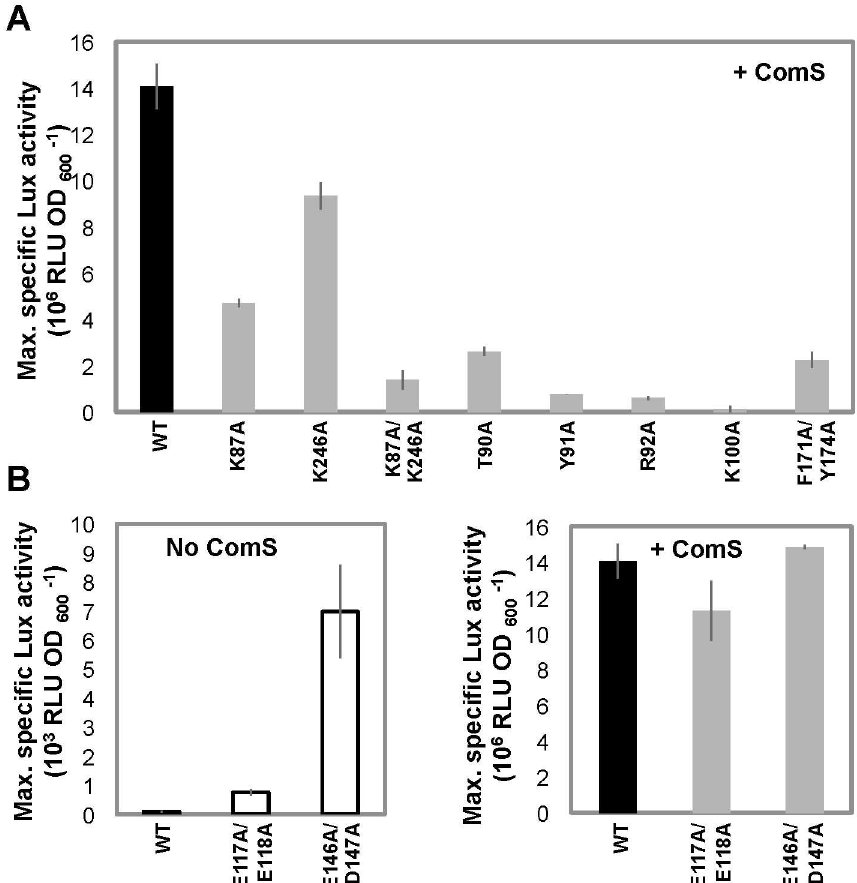
Fig 6. In vivo transcriptional activity. A– In vivo activities of ComR mutants affected in dimerization, XIP binding and activation mechanism. Maximum specific luciferaseactivity (RLU OD 600-1 ) emitted by the ComS - reporter strain producingComR WT (black bar) and ComR mutants K87A, D246A, K87A/D246A, T90A, Y91A, R92A, K100A, F171A/Y174A (gray bars) grown in presenceof 50 nM XIP. B– In vivo activities of ComR mutants affected in HTH sequestration. Maximum specific luciferase activity of the ComS - reporter strain producing ComR WT (black bars) and ComR mutants E117A/E118A and E146A/D147A grown without (white bars) or with 50 nM XIP (gray bars). Bars represent the averageof three independent repeats ± standarddeviation.